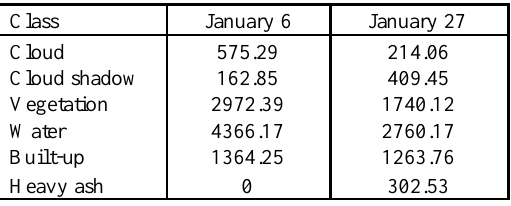
Table 2 . Area of each land cover (km 2 ) before and after the 2020 Taal volcano eruption